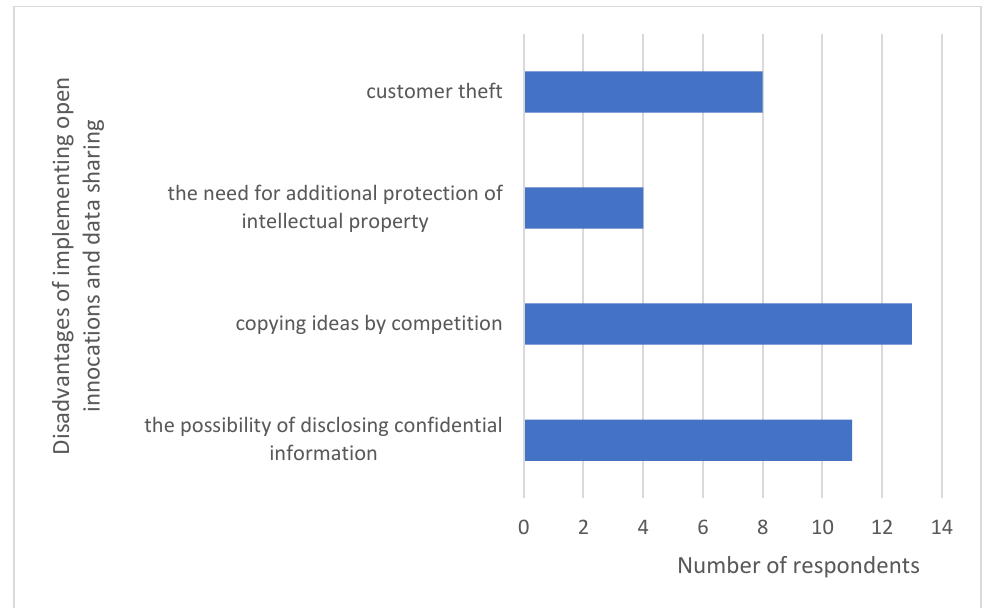
Figure 7. Disadvantages of implementing open innovations and data sharing in car-sharing systems.